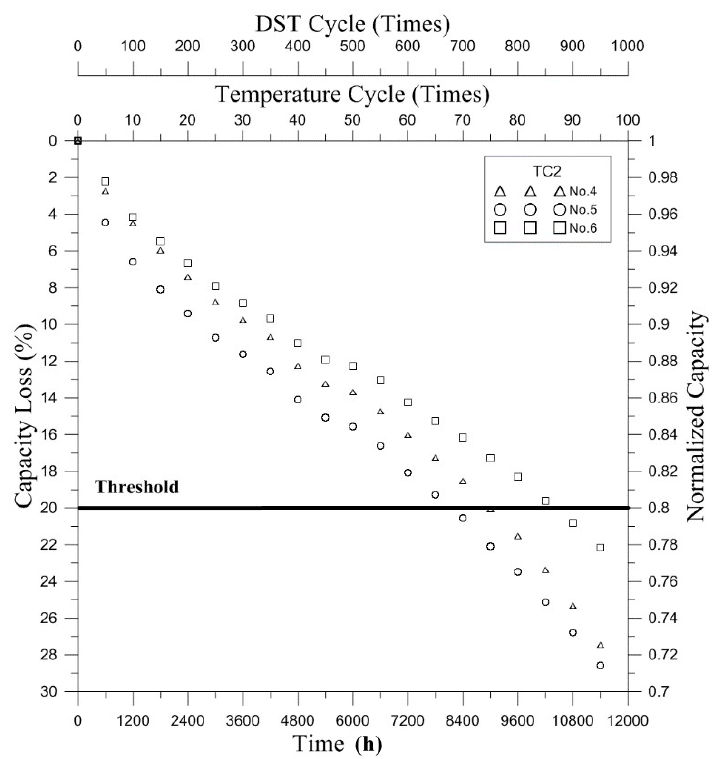
Figure 6. The capacity loss of the test batteries during D 2 SADT (TC2 condition). Appl. Sci. 2018 , 8 , x FOR PEER REVIEW